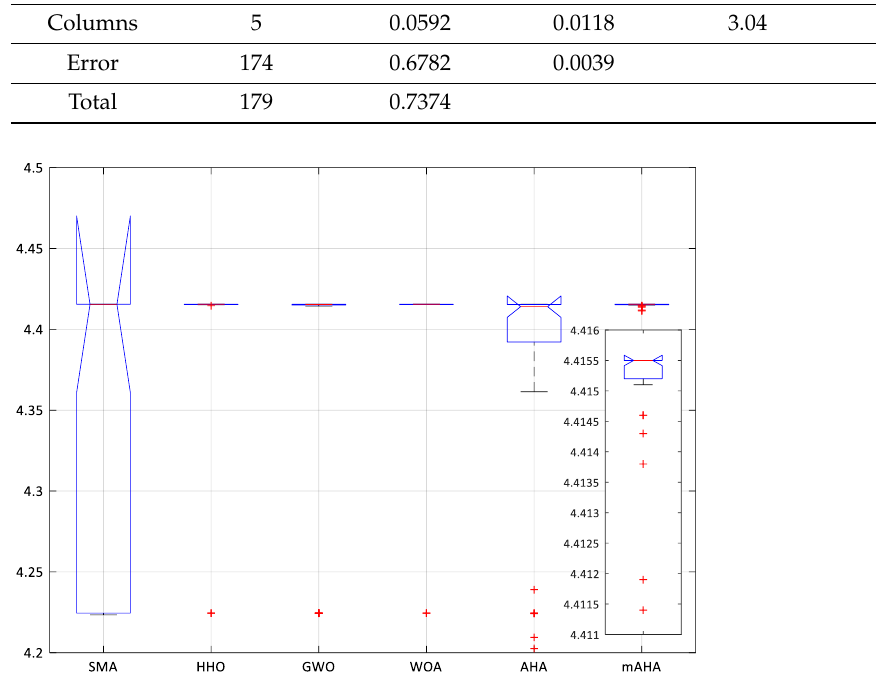
Figure 10. ANOVA ranking for the second shadow scenario.